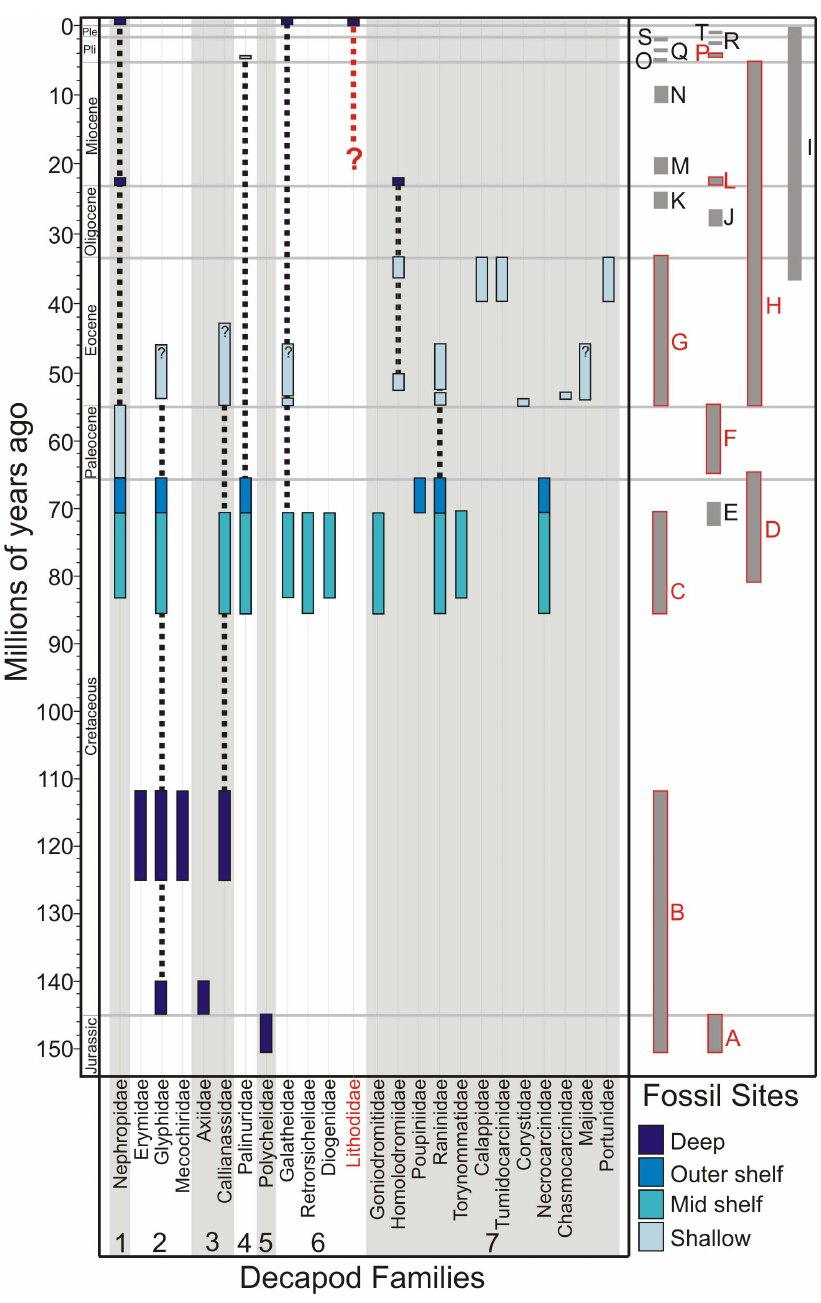
Figure 2. Ranges of fossil decapods in Antarctica. Bars represent family ranges, colours show water depth of depositional unit in which the fossils were found. Dotted lines are inferred ranges between occurrences. ?=inferred position for end of a range. Red dashed line indicates the uncertainty of the fossil history of the Lithodidae due to the complete lack of a fossil record. All known marine macrofossil sites are shown on the right hand side (grey bars). Red letters indicate the sites in which crab fossils were found. References for ranges, unit water depths and fossil sites are given in Appendix S1. Infraorders labelled as; 1=Astacidea, 2=Glypheidea, 3=Axiidea, 4=Achelata, 5=Polychelida, 6=Anomura & 7=Brachyura. Stratigraphic units labelled as; Nordenskjo¨ld Formation=A, Fossil Bluff Formation=B, Santa Marta Formation=C, Lo´pez de Bertodano Formation=D, Snow Hill Island Formation=E, Sobral Formation=F, La Meseta Formation=G, McMurdo Sound erratics=H, DSDP drill holes=I, Polonez Cove Formation=J, Destruction Bay Formation=K, Cape Melville Formation=L, Battye Glacier Formation=M, Hobbs glacier Formation=N, Prospect Mesa gravels=O, Bull Pass Formation=Q, Scallop Hill Formation=R, Cockburn Island Formation=S and Weddell Sea Formation=T, Sørsdal Formation=P. doi:10.1371/journal.pone.0066981.g002 the biogeography of the Lithodidae and seafloor temperature and The first crabs to be labelled as ‘invasive’ in Antarctic waters were the first to quantify the known temperature limits of the SO were two individuals of Hyas araneus found at the South Shetland lithodids, giving examples of cold tolerant and cold intolerant Islands [30]. Tavares and De Melo [30] postulated that these species from the three genera present in the region. brachyuran crabs, usually found in the North Atlantic and Arctic